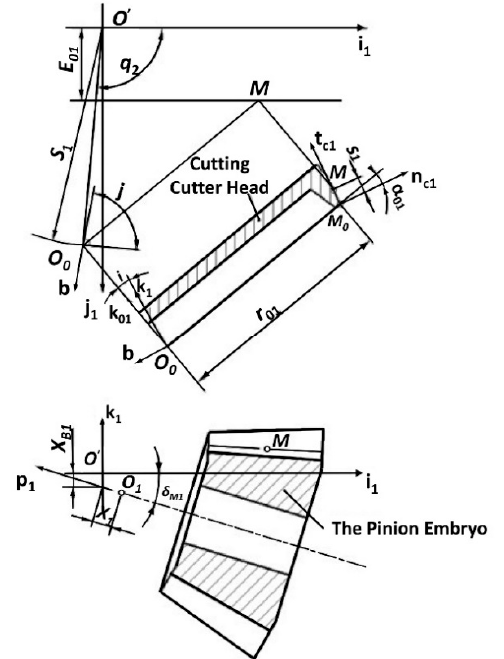
Figure 3. Position relationship between the pinion embryo and cutting cutter head.